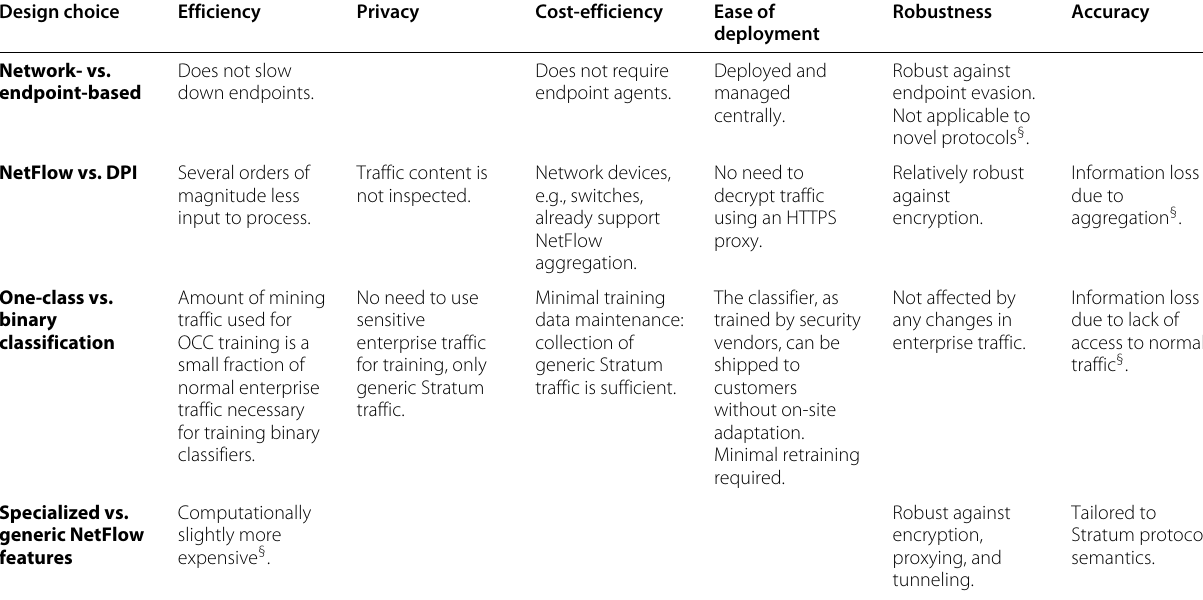
Table 2 Summary of benefits and drawbacks of XMR-R AY ’s design Design